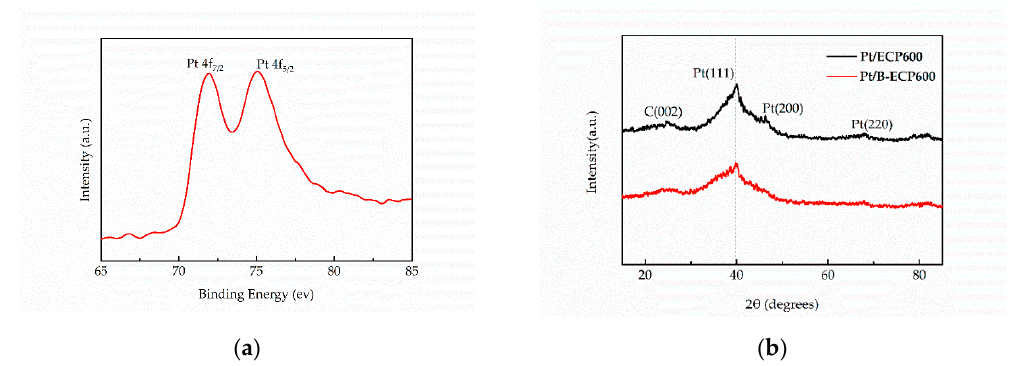
Figure 4. ( a ) XPS patterns of Pt 4f for Pt/B-ECP600; and ( b ) XRD results of ECP600 and B-ECP600.